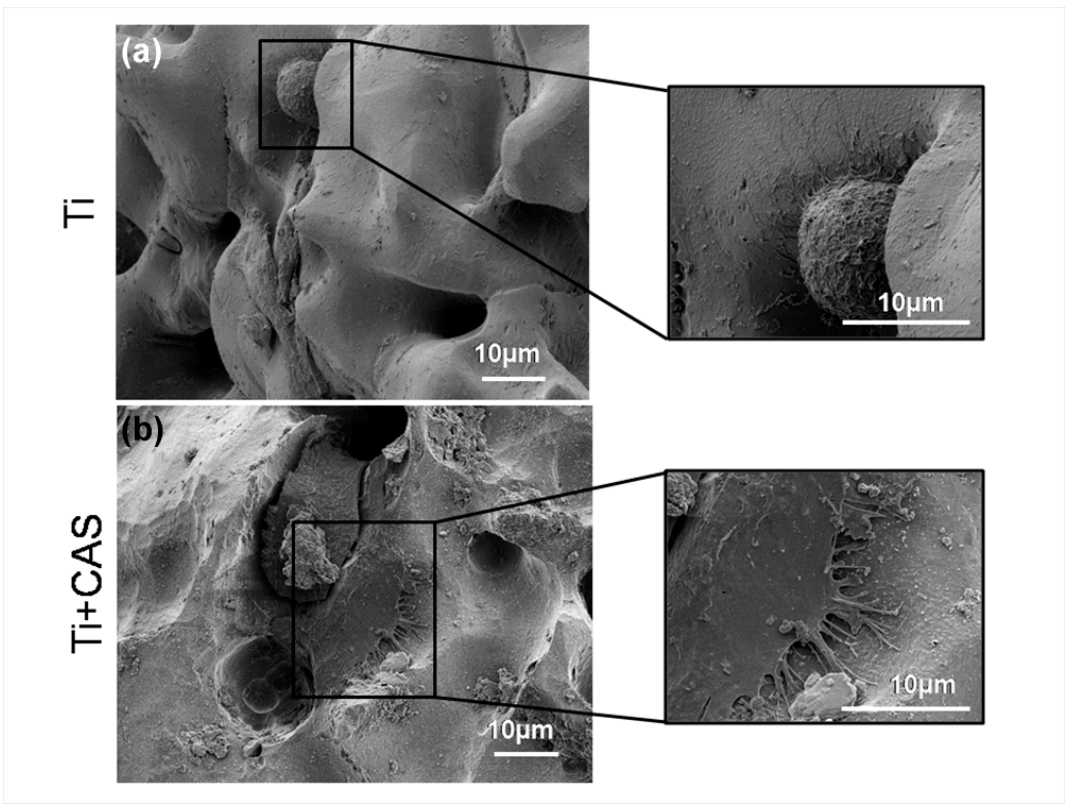
Figure 7. SEM images of SaOS-2 cells after the initial 6 h of culture: ( a ) on pristine Ti scaffolds and ( b ) on Ti scaffolds functionalized with cell attachment fragment (CAS) fragments.